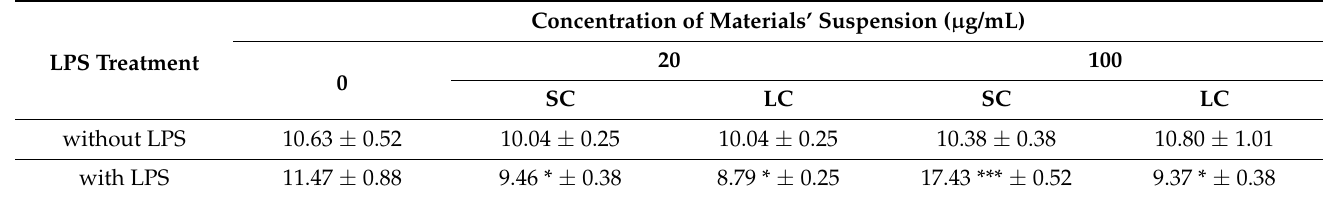
Table 3. Concentration of nitrites ( µ M) in macrophage cell culture media, measured by Griess